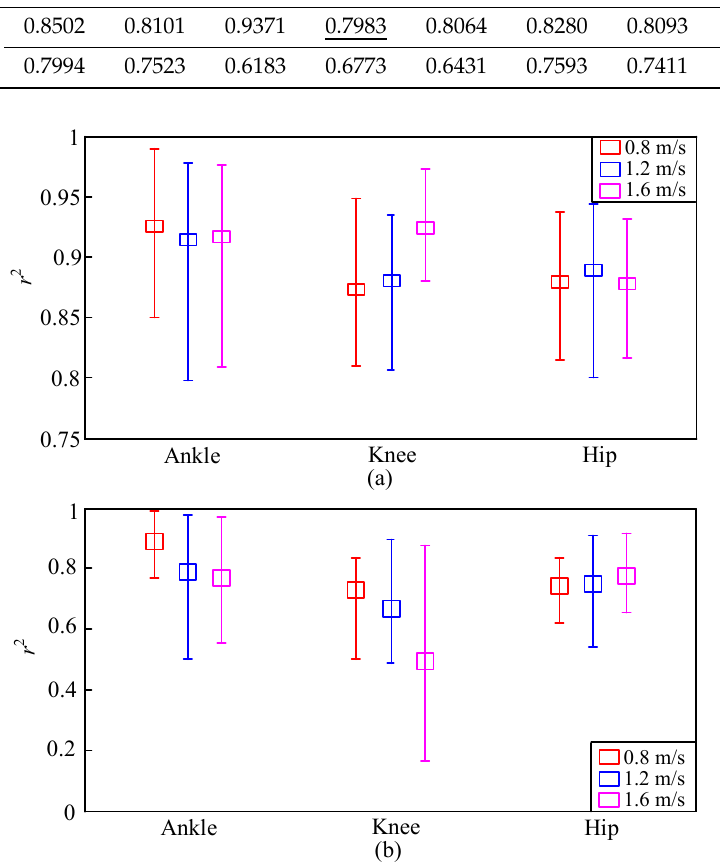
Figure 6. r 2 values of ( a ) proposed DGP and ( b ) GP models.